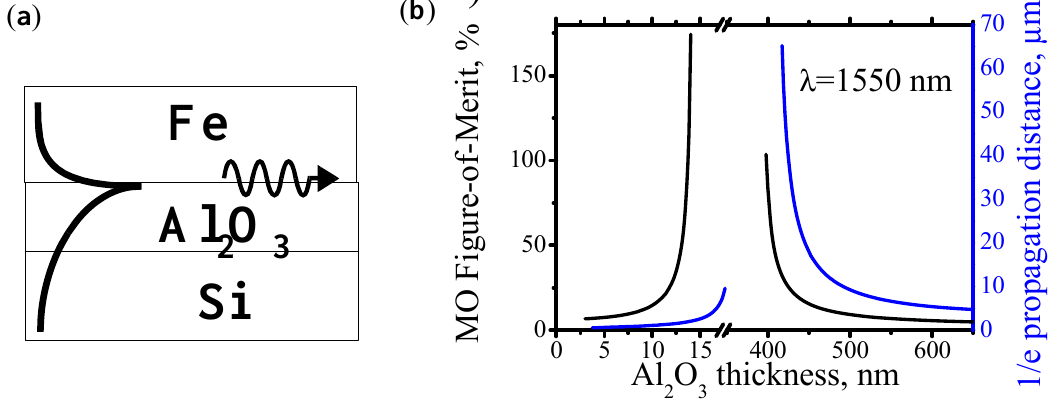
Figure 4. ( a ) Structure of Fe/Al ( b ) Magneto-optical Figure-of-Merit and 1/e propagation distance for plasmons in O /Si plasmonic Fe/Al 2 3